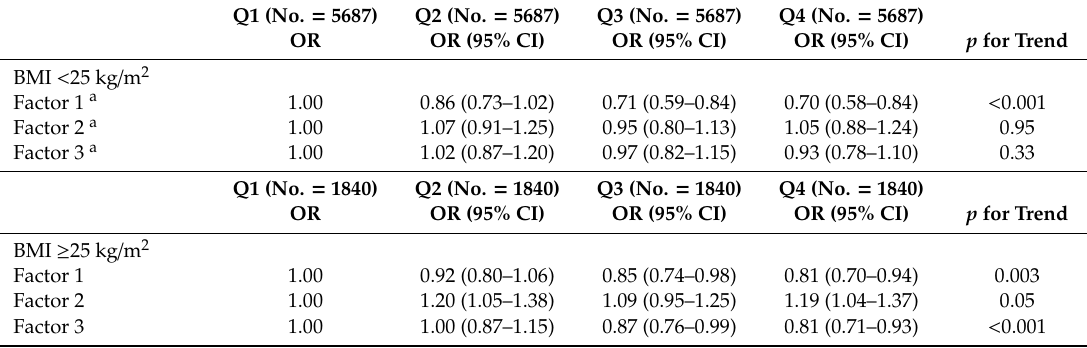
Table 6. Associations of nutrient pattern scores with metabolic syndrome according to body mass